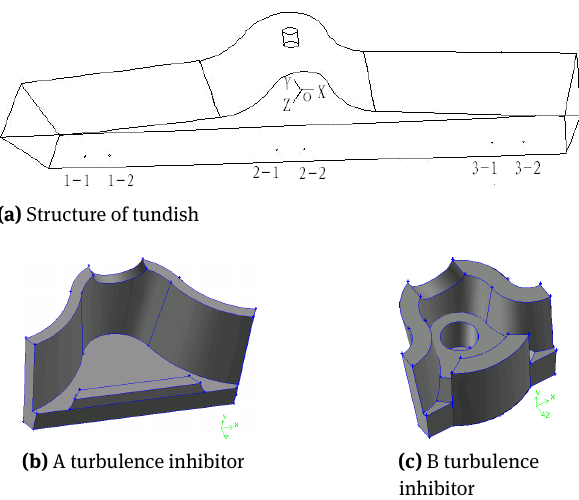
Figure 4: Structures of tundish and designs of two turbulence in-